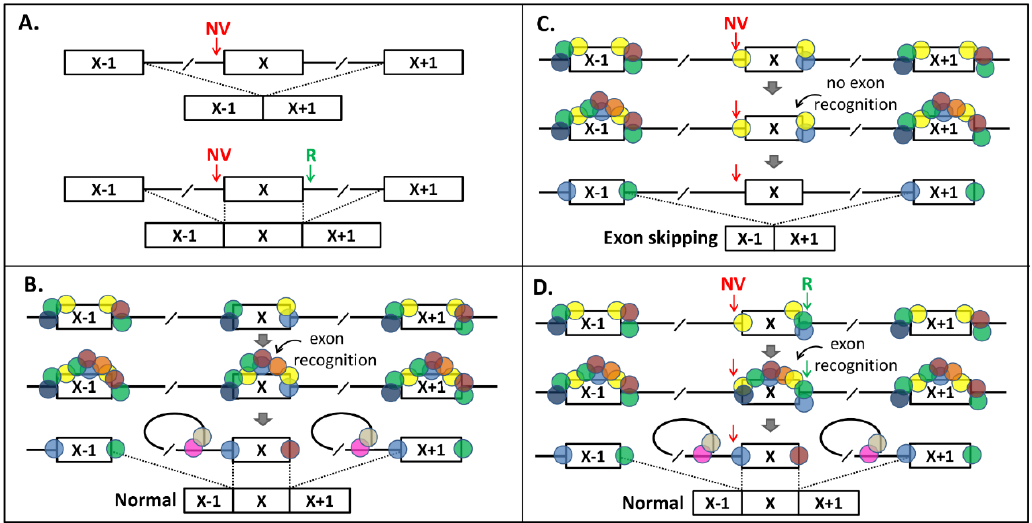
Figure 4. Splice-site-interdependency-based exon skipping rescue model. ( A ) Principle of rescue of Exon X skipping due to a noncanonical splice-site (NCSS) variant (NV) at the 3 (cid:48) splice site (upper panel) by strengthening the 5 (cid:48) splice site with a “rescue variant” (R, lower panel). ( B ) In normal splicing of Exon X, upon binding of splice junction sequence motifs by splice factors, additional splice factors will bind and define the exon, which is followed by the lariat configuration and normal splicing. Absence of one or more splice-enhancing motifs in Exon X makes this exon vulnerable to exon skipping when a NV variant is present, because the number of splice factors binding to Exon X is only just enough for exon definition. ( C ) In the presence of a NV in the 3 (cid:48) splice site, insu ffi cient splice factors will bind and there is no exon definition. ( D ) By strengthening the 5 (cid:48) splice site with the “R”, additional splice proteins can bind and the exon definition and normal splicing are restored.